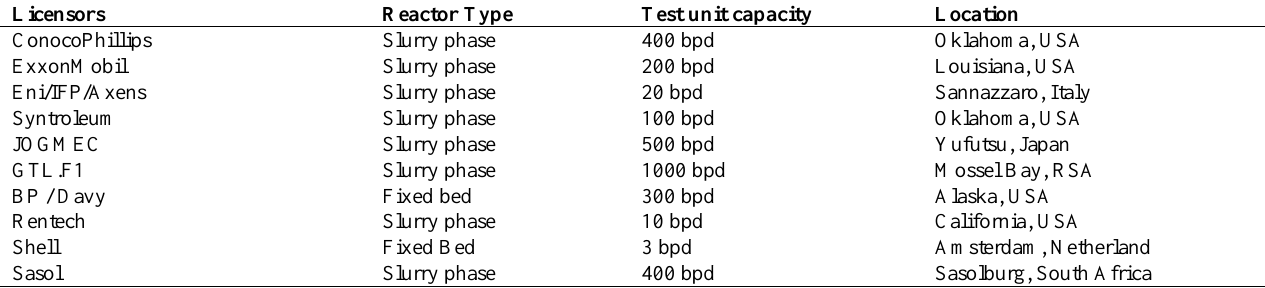
Table 1: Overview of the FT synthesis licensors